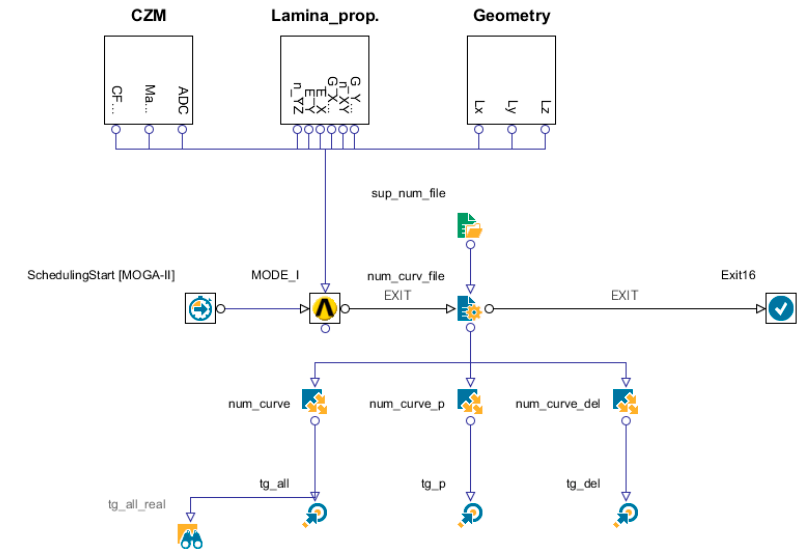
Figure 12. ModeFRONTIER workflow for the numerical/experimental calibration. CZM—cohesive zone